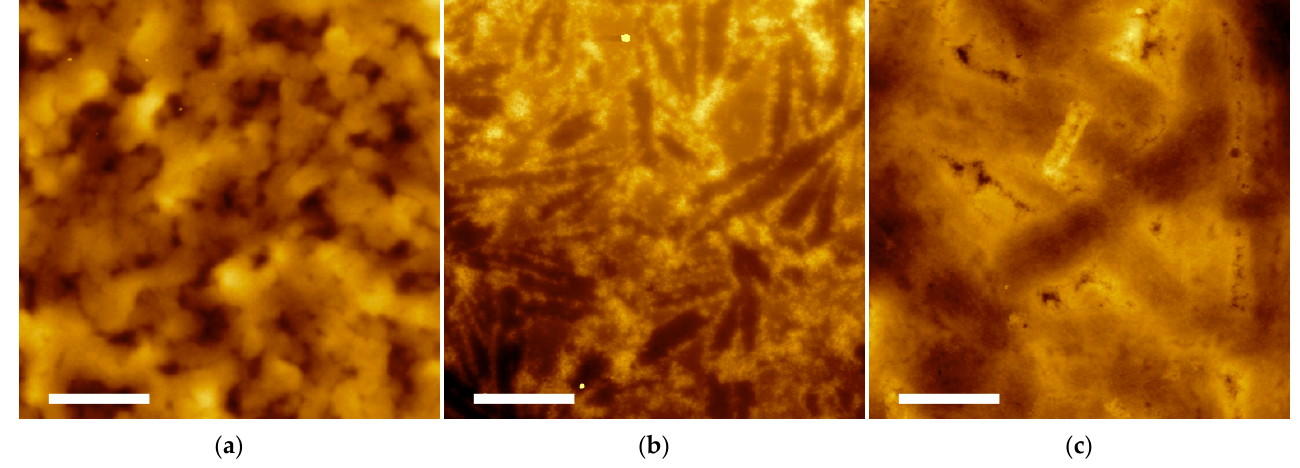
Figure 6. AFM topography images of hydrogel H5 ( a ), H6 ( b ), and H7 ( c ) recorded on samples deposited on silicon wafers after 24 hr of gelation. Scale bar represents 5 μ m.